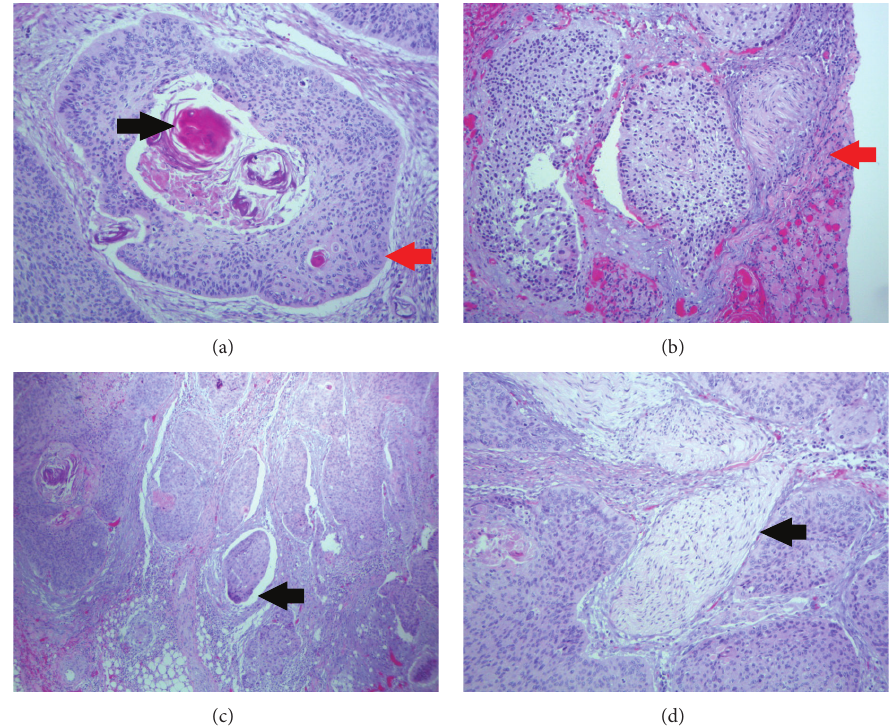
Figure 3: (a) Histopathological examination showing a moderately differentiated squamous cell carcinoma with keratinization ( × 100). Keratin pearl (black arrow). Mosaic cell arrangement with sharp border (red arrow). (b) Tumor invasion of the diaphragm ( × 100) (red arrow). (c) Lymphovascular invasion is present ( × 40) (black arrow). (d) Tumor with nerve invasion ( × 40) (black arrow).